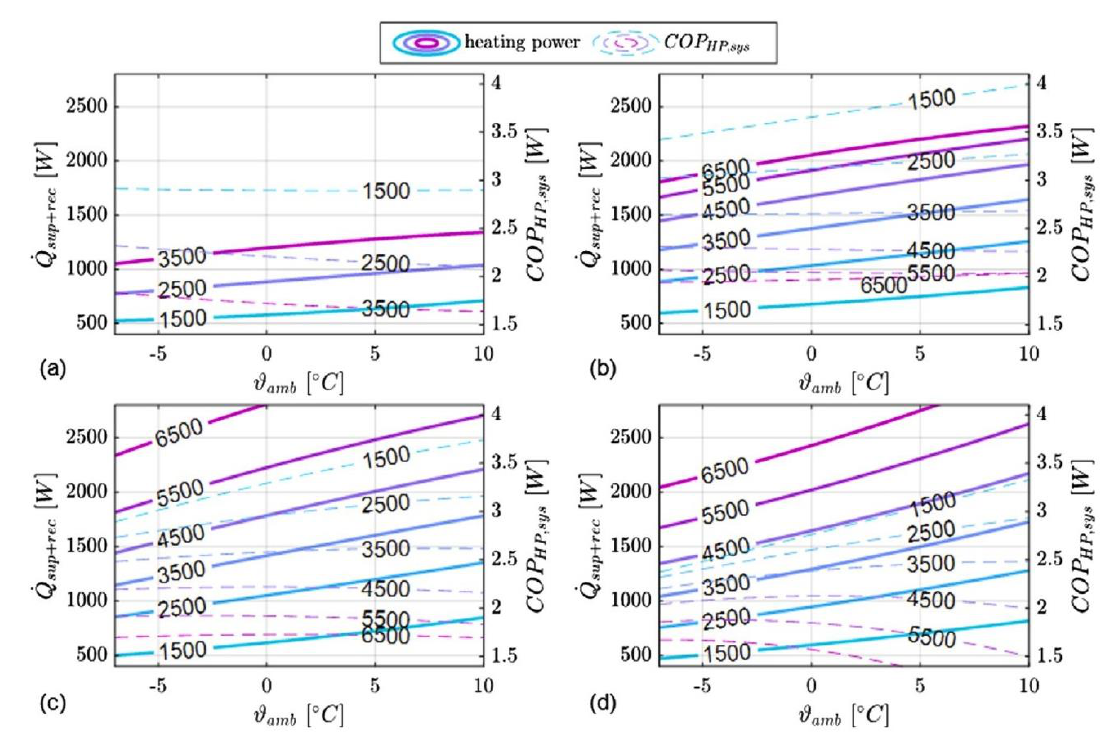
Figure 13. Measured heating power and system COP for the 2.5 kW heat pump under different compressor speeds as a function of the ambient air temperature. ( a ) 100 m 3 /h supply air with no additional ambient air. ( b ) 100 m 3 /h supply and secondary air with no additional ambient air. ( c ) Similar to ( b ) with 200 m 3 /h additional ambient air. ( d ) 100 m 3 /h supply and secondary air with no exhaust air but only 300 m 3 /h ambient air [11].